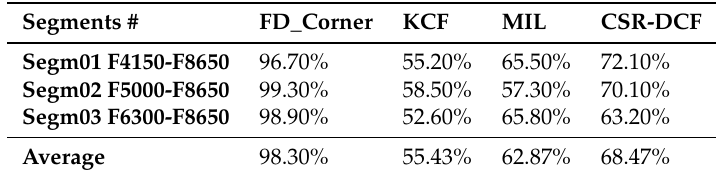
Table 7. Comparison of the baseline and stare of art trackers with FD_Corner in terms of robustness to initialisation. A tracker was initialized at different frames on sequence 2. FD_Corner tracker obtain the best result.